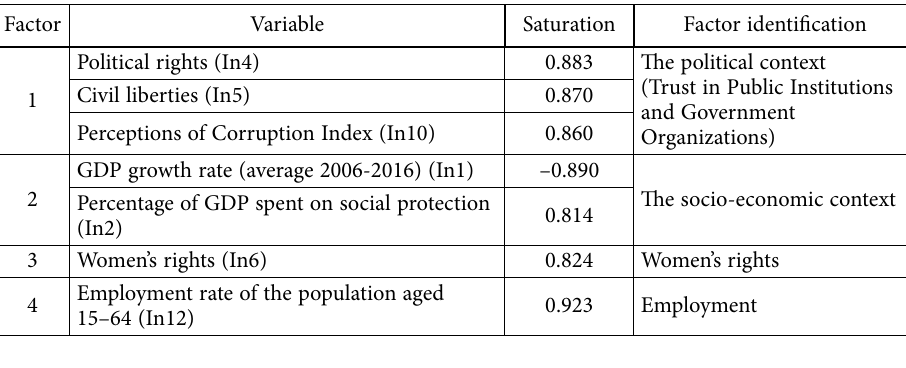
Table 4 . Identifying factors after factor